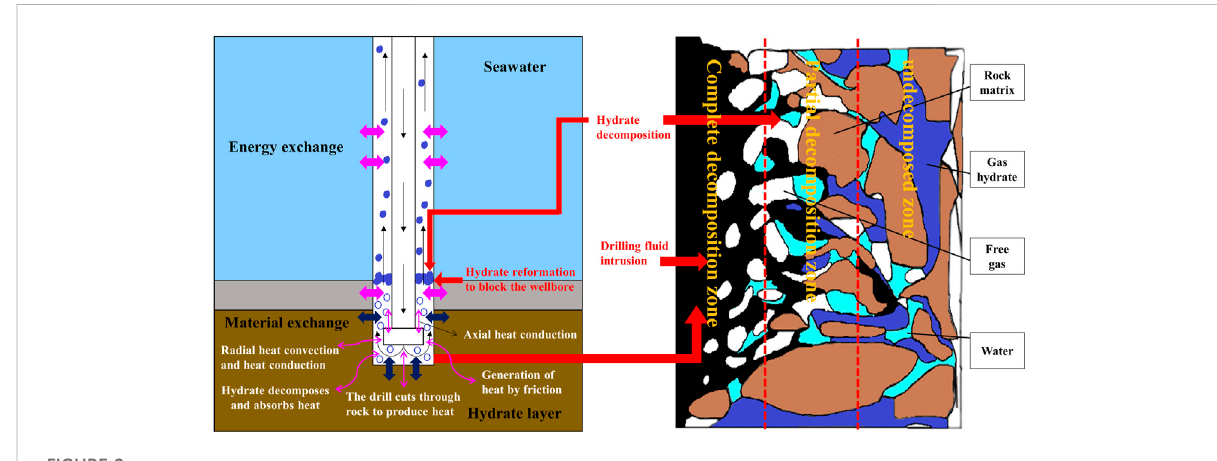
FIGURE 2 Drilling fl uid invasion pro fi le around the wellbore. The boundary and distance between zones do not represent the actual boundary and